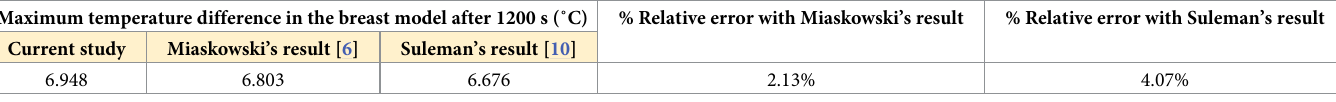
Table 3. Comparison between present simulation results and Miaskowski et al. and Suleman et al.’s simulation results [6, 10]. Maximum temperature difference in the breast model after 1200 s (˚C) % Relative error with Miaskowski’s